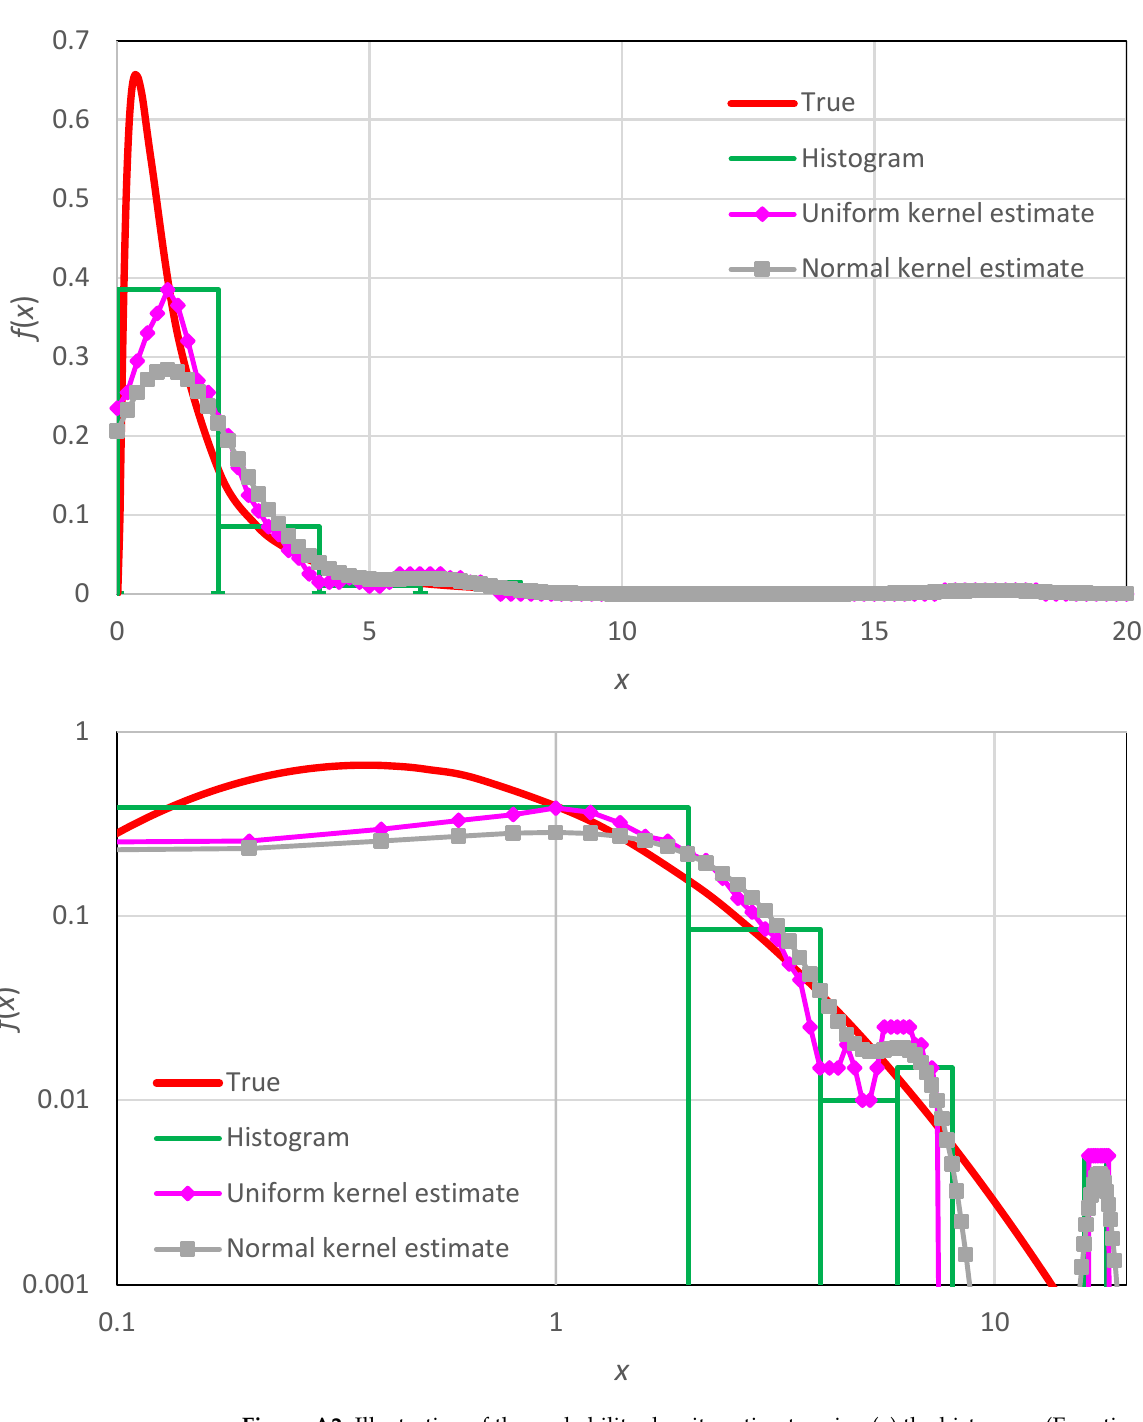
Figure A2. Illustration of the probability density estimate using (a) the histogram (Equation (4) with 10 bins for the range [0, 20]), (b) the uniform kernel (Equation (A2) with h = 1) and (c) the normal kernel (Equation (A3) with h = 1), plotted in Cartesian ( upper ) and logarithmic ( lower ) axes. The data series of Figure 1 was used ( n = 100 values, generated from a lognormal distribution with parameters ς = λ = 1; see Table 2).